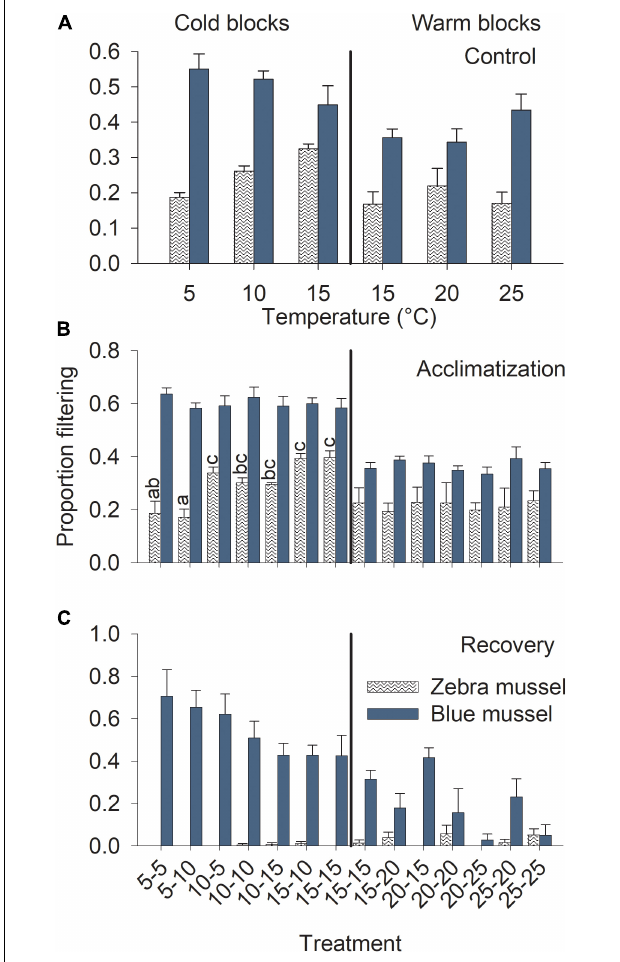
FIGURE 6 | Filtration activity of marine blue mussels ( Mytilus edulis ) and freshwater zebra mussels ( Dreissena polymorpha ) in the control treatments at different temperatures (A) and during the acclimatization (B) and recovery (C) phases of the experiment. Bars show mean (+SE, n = 4) proportion of individuals observed filtering and columns not sharing a common letter (within a Block and Species combination) are significantly different (Tukey post hoc tests). Vertical lines show the separation between the cold and warm blocks.